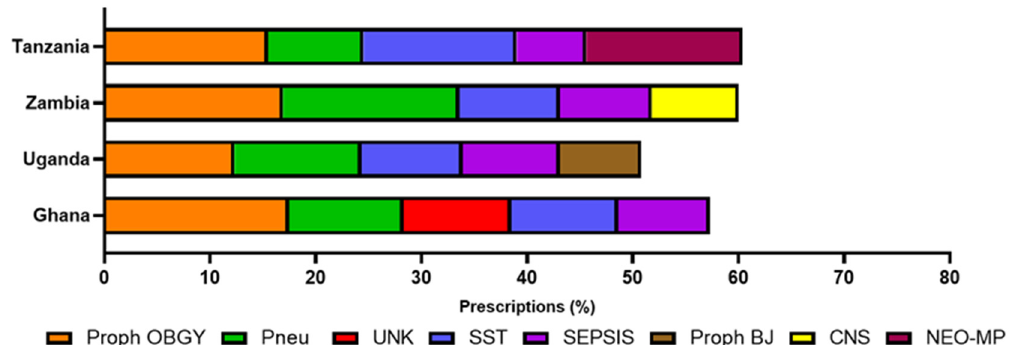
Figure 2. Most common reason for prescribing antimicrobials across 17 hospitals participating in the PPS.